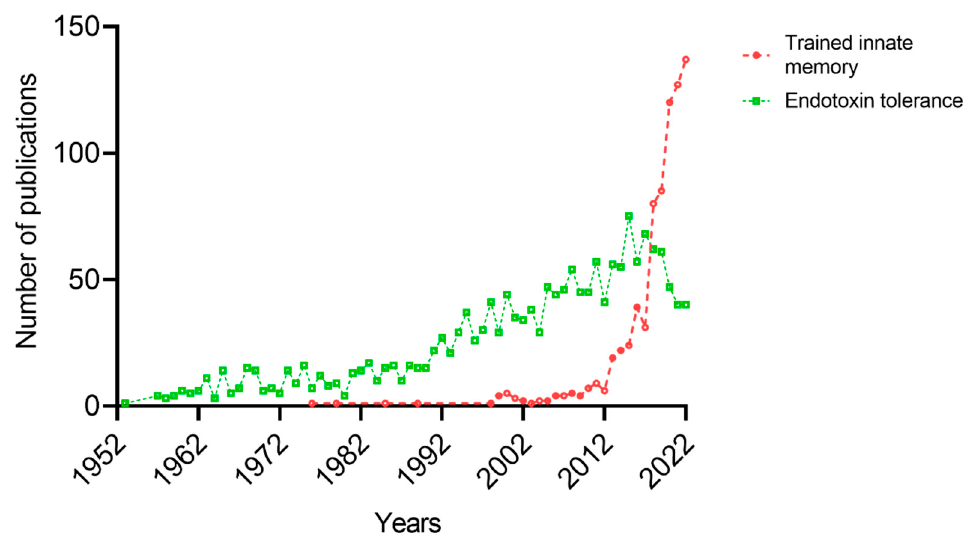
Figure 1. Number of publications related to trained innate memory and endotoxin tolerance as adaptive manners (PubMed, January 2023).